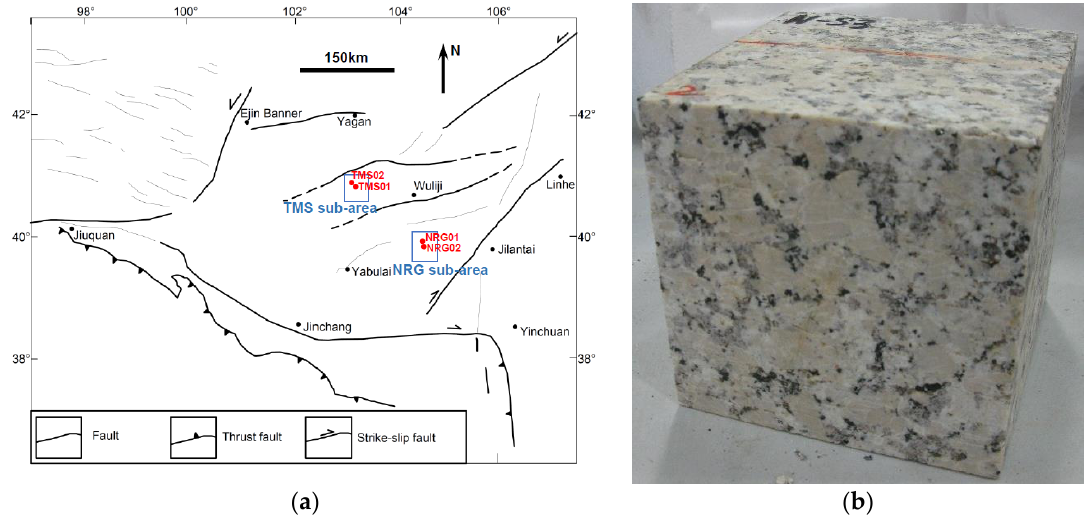
Figure 2. ( a ) Schematic map of main geological structures around the Alxa area [22,62]. TMS01, TMS02, NRG01, and NRG02 are four boreholes drilled in TMS and NRG sub-areas. The samples in this study were taken from a quarry near the NRG01 borehole. ( b ) Cubic granite samples (approximately 100 × 100 × 100 mm) used in the direct shear tests.